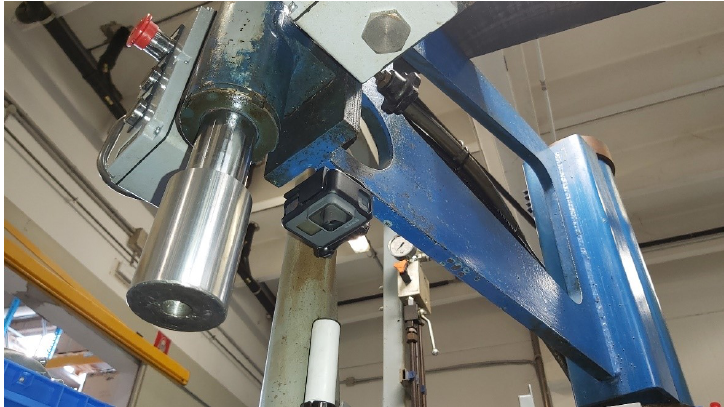
Figure 15. Camera mock-up showing the point of